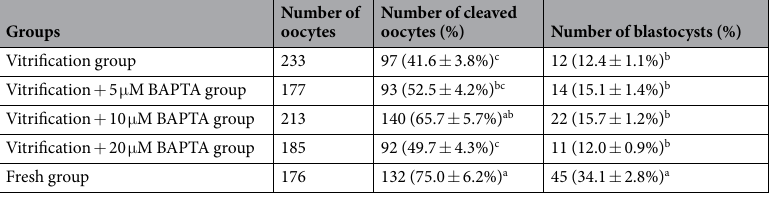
Table 3. Effect of BAPTA treatment on the developmental ability of vitrified bovine oocytes after IVF. a,b,c Values with different superscripts differ significantly within the same column ( P < 0.05).